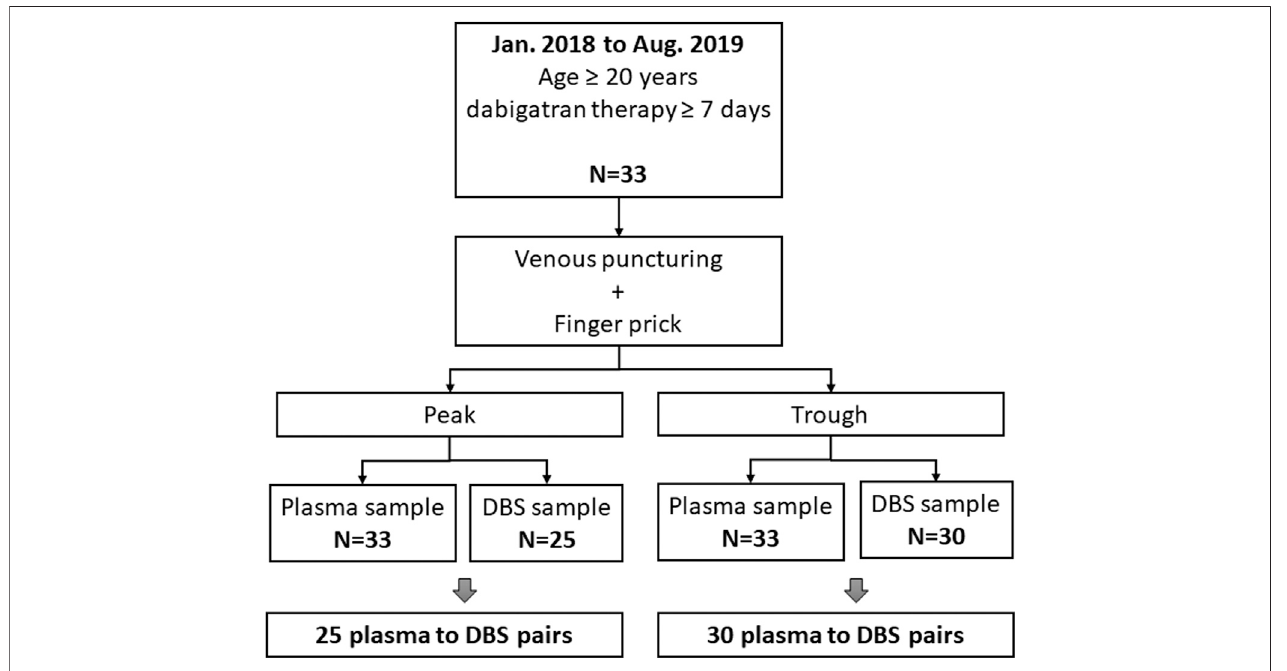
FIGURE 1 | The process of study